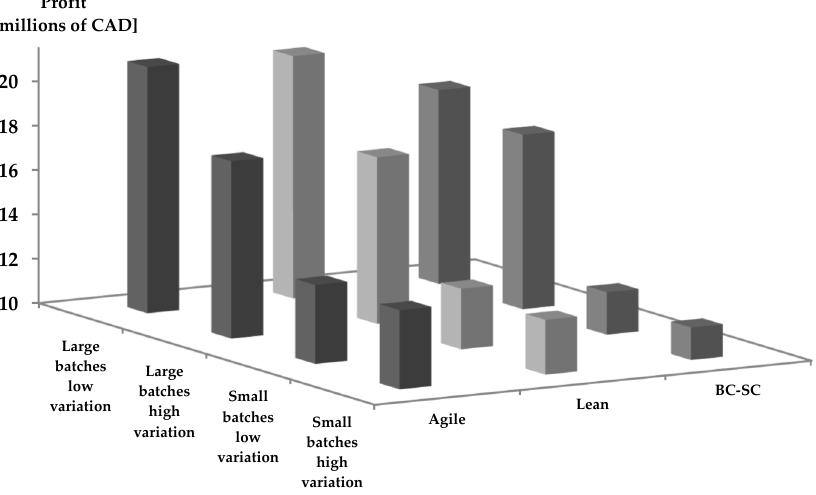
Figure 2. Profits variation between MEs and lumber demand scenarios (LDSs).